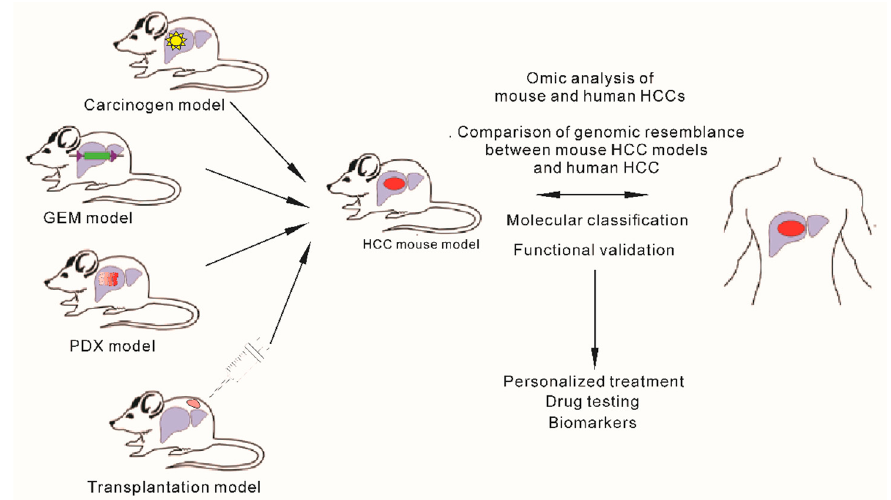
Figure 1. Schematic diagram of mouse models commonly used to develop hepatocellular carcinoma and integration of human and mouse genomics to select appropriate model for clinical therapeutic purpose.